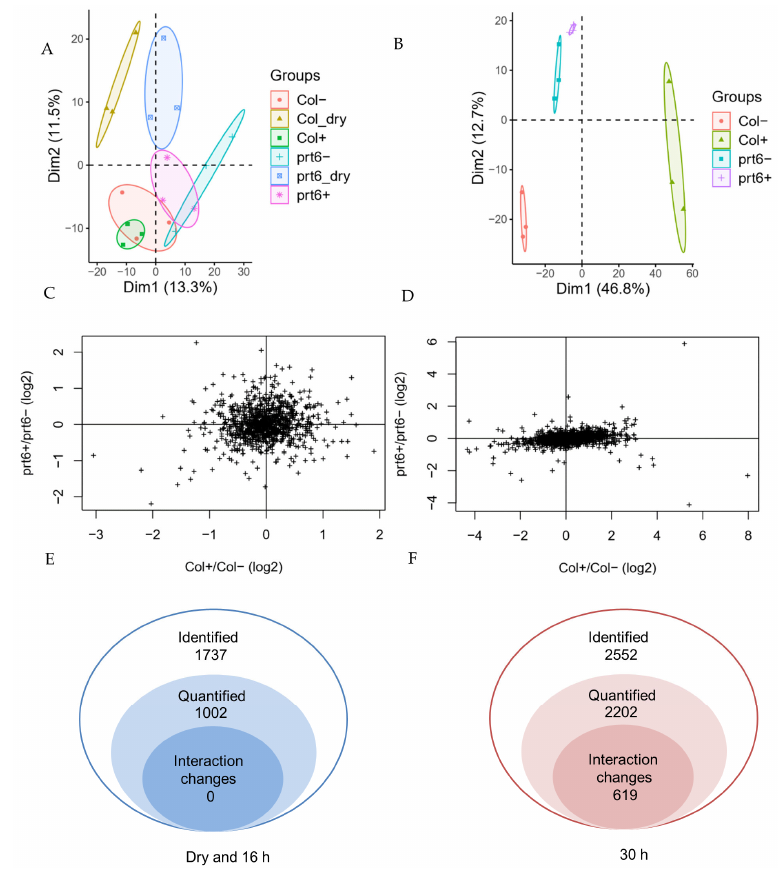
Figure 2. Effects of ethylene on the 16 and 30 h-proteome in Arabidopsis seeds (Col and prt6 ). ( A , B ): The number of identified, quantified and significantly changed proteins in label-free quantification by the XIC method from seed proteome of dry seeds and 16 h-imbibed seeds ( A ) and 30 h-imbibed seeds ( B ). ( C , D ): Scatter plots of the log 2 transformed ratio (Col+/Col − versus prt6+/prt6 − ) for 1002 proteins from “dry and 16 h” proteomes ( C ) and 2202 proteins from 30 h-proteome ( D ), + represents the presence of ethylene treatment, − Represents the absence of ethylene treatment. ( E , F ): Principal components analysis (PCA) of the protein quantification for 1002 proteins from proteomes in dry and 16 h ‐ imbibed seeds ( E ) and 2202 proteins from 30 h ‐ imbibed seed proteome ( F ), each dot corresponds to one of the replicates, each circle indicates 95% confidence interval of each condition. Seeds harvested in 2016.